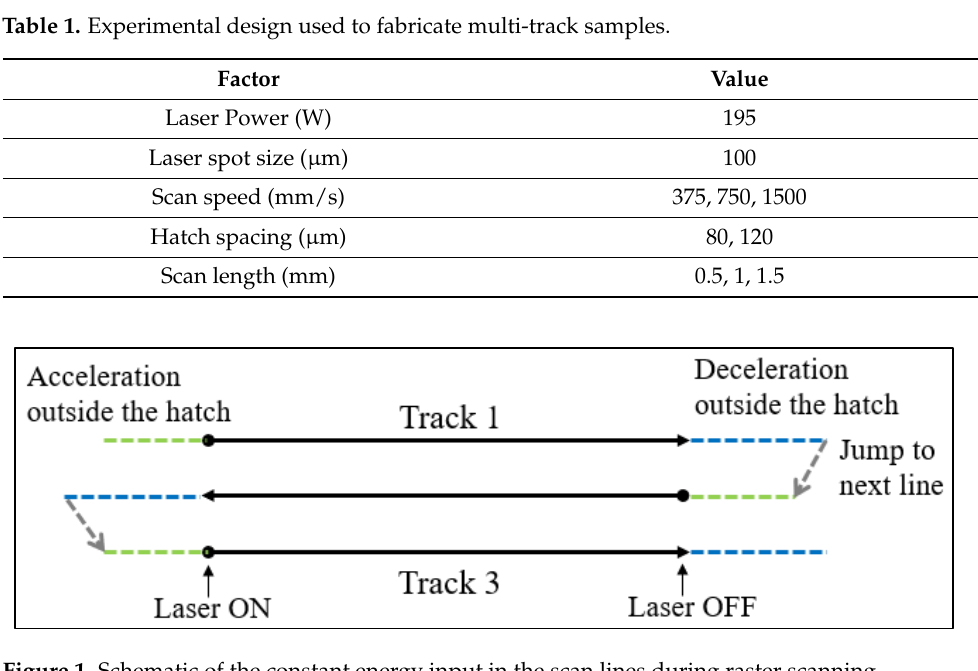
Table 1. Experimental design used to fabricate multi-track samples.